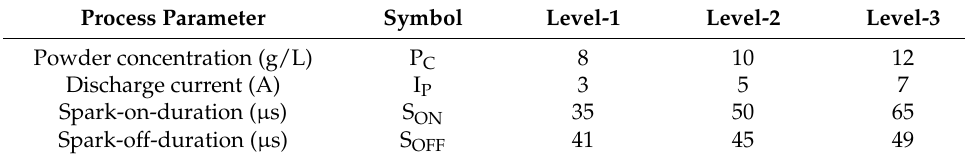
Table 3. Experimental Machining Conditions.